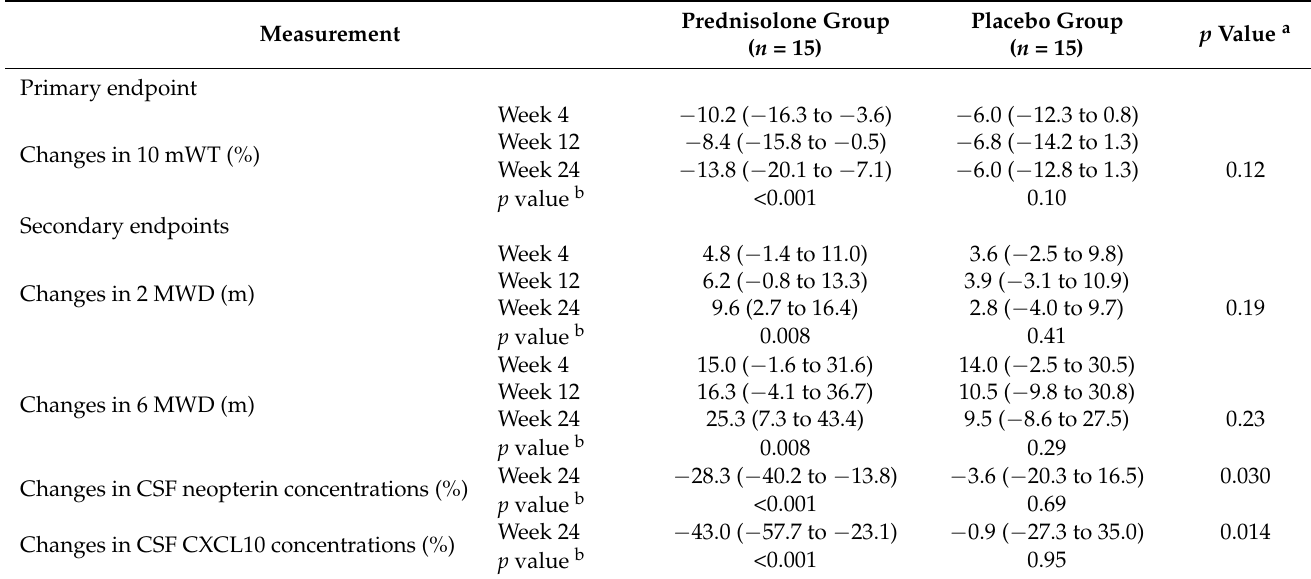
Table 4. Main outcomes in slow